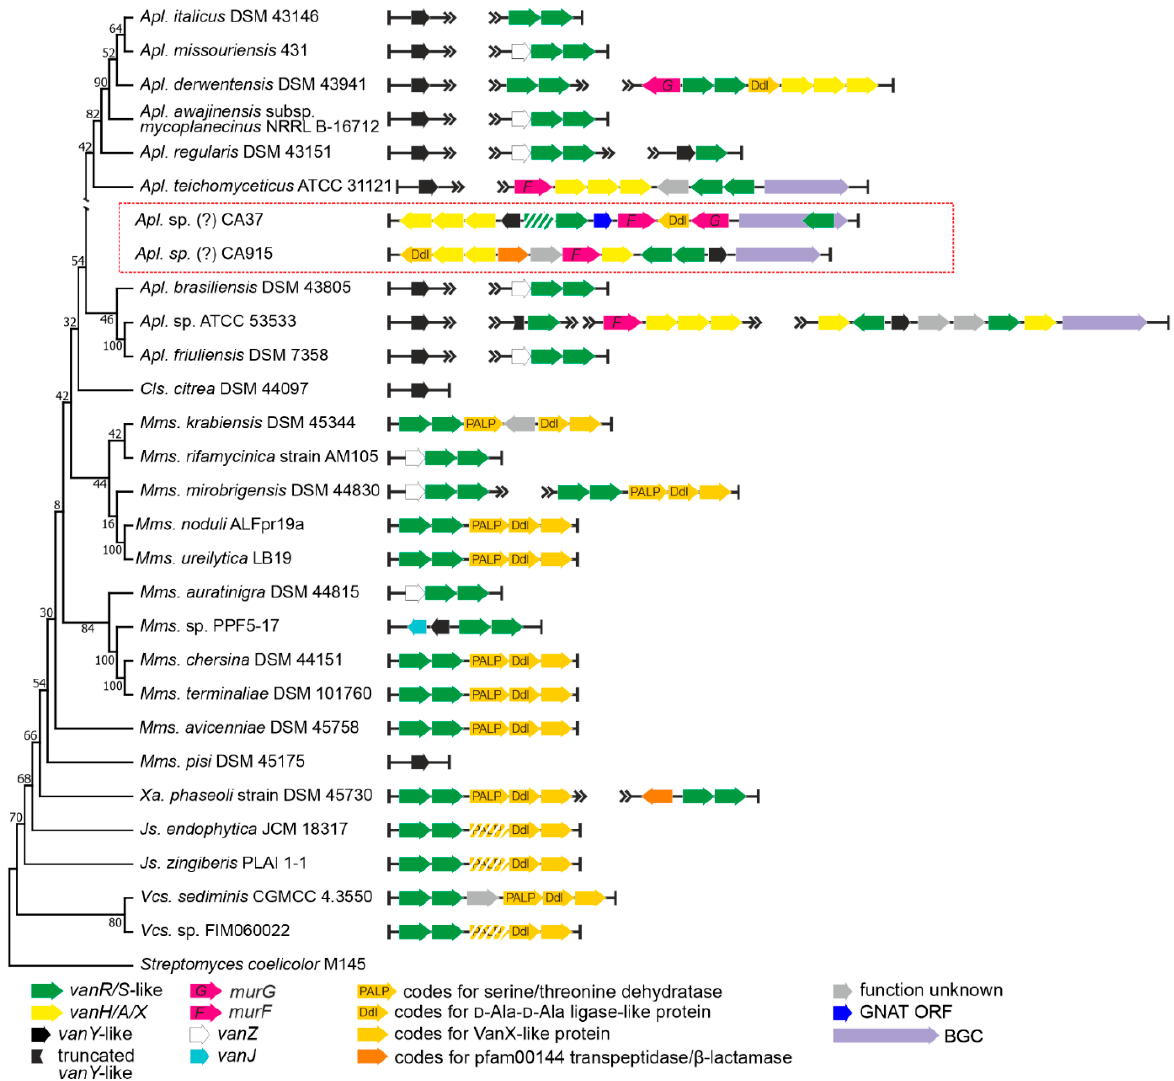
Figure 4. Organization of vlgs found within the set of 28 chosen genomes of Micromonosporales spp. Maximum Likelihood phylogenetic tree of the 16S rRNA genes of the corresponding species (see Section 4 for details) served as a phylogenetic framework for the scheme. Names of the Micromonosporales genera were abbreviated according to ESM Table S1. vlgs from the metagenomic CA915 and CA37 BGCs (highlighted with red frame) were arbitrarily introduced within the scheme since the retrieved sequences likely belong to some Actinoplanes spp. The legend below the figure explains the color-coding of the scheme. Please refer to the text for the role of the single genes. Pseudogenes are shaded.